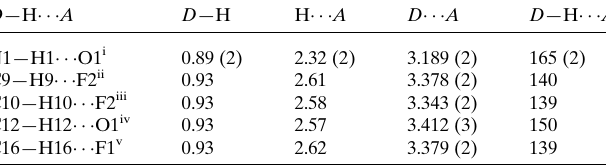
Table 2 Hydrogen-bond geometry (A˚ , (cid:2) ) for